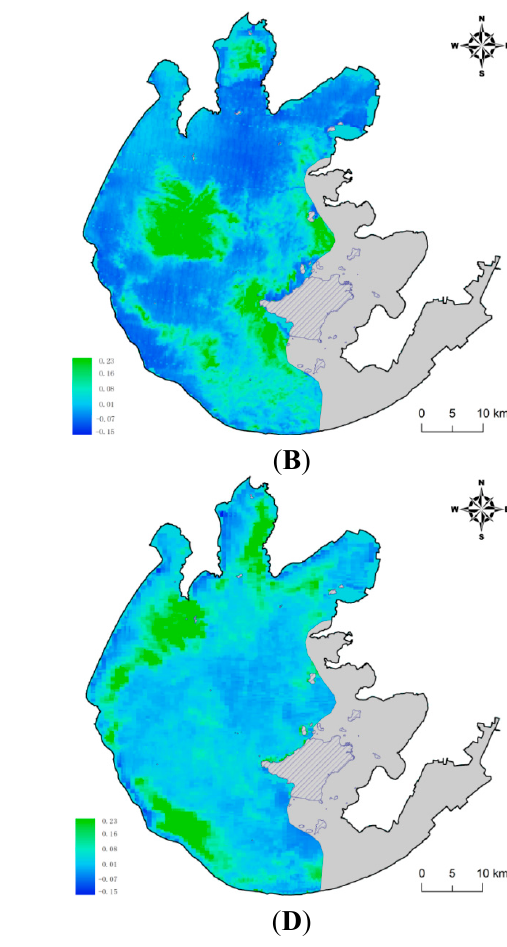
Figure 3. Tendency variation of algae areas within three lake divisions from 2000 to 2012 (W: winter; SP: spring; S: summer; A: autumn).